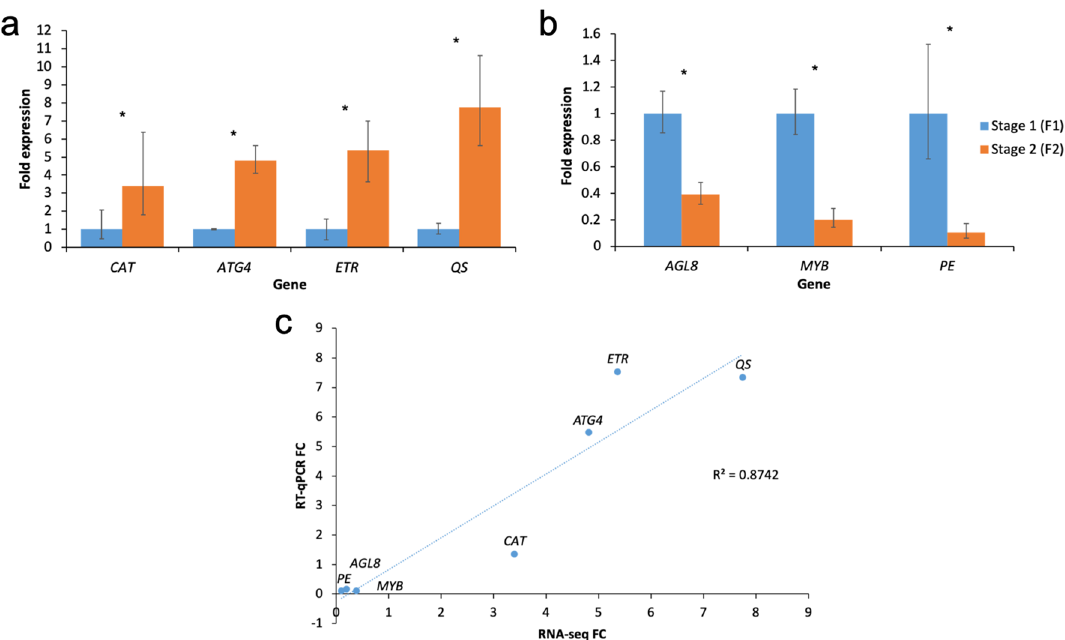
Figure 5. RT-qPCR analysis on the fold change of expression level at F2 relative to expression level at F1. ( a ) Unigenes with up-regulated expression. ( b ) Unigenes with down-regulated expression. ( c ) Correlation plot between the RT-qPCR fold-change (FC) compared to FC calculated from TPM values of RNA-seq analysis. Genes studied are CAT CATALASE , ATG4 AUTOPHAGY-RELATED , ETR ETHYLENE RECEPTOR , QS QUINOLINATE SYNTHASE , AGL8 AGAMOUS-LIKE 8 , MYB MYELOBLASTOSIS , and PE PECTIN ESTERASE . Asterisks indicate significant differences ( P < 0.05) in gene